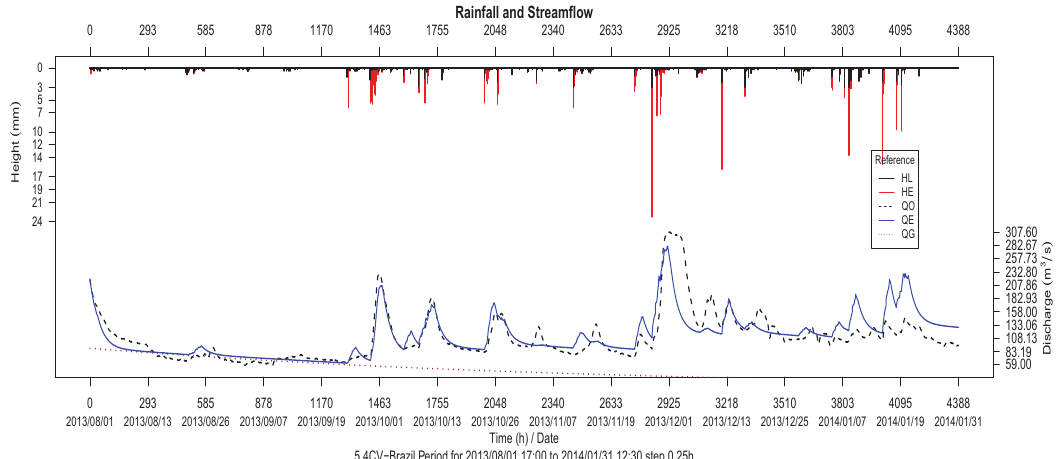
Figure 17. Hyetograph and Hydrograph from validation data series 5.4CV of Juquiá river at 4F-018R.